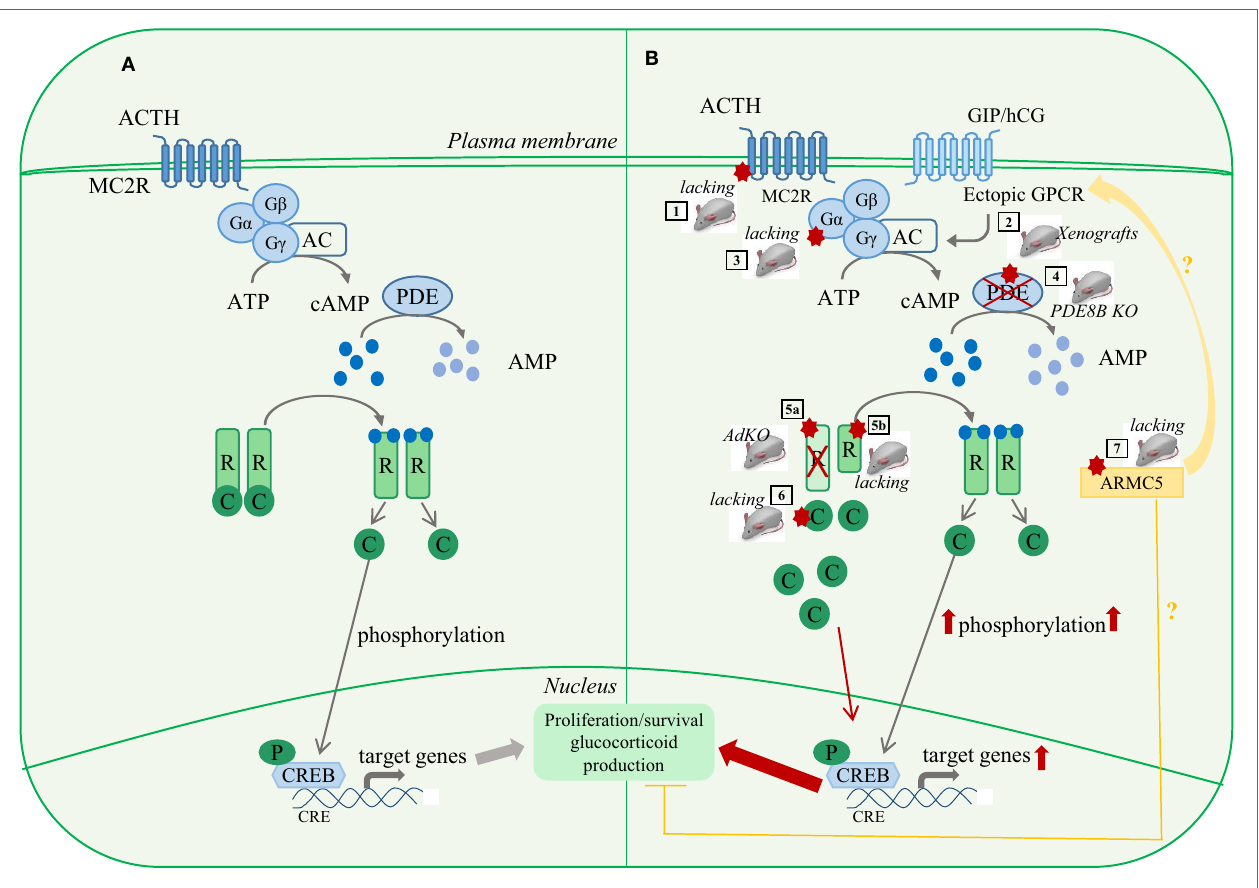
FiGURe 1 | PKA signaling pathway in adrenal tumorigenesis and related mouse models . (A) Under normal conditions, ACTH binds to MC2R, a G-protein-coupled receptor (GPCR) that activates adenylate cyclase (AC) via Gs α , thus increasing intracellular levels of cAMP. Upon binding of cAMP to regulatory subunits (R) of PKA, the complex dissociates releasing the catalytic subunits (C) which in turn phosphorylate (among others) the cAMP-responsive element-binding protein (CREB). Once phosphorylated, CREB transcription factor regulates the expression of steroidogenic and proliferative genes. In absence of ACTH, the pathway is repressed through the activity of several phosphodiesterases (PDE) that inactivate cAMP. (B) Molecular alterations of several components of cAMP/PKA signaling pathway cause adrenal hyperplasias and tumors. (1) Activating mutations of MC2R found in PBMAH patients lead to higher activation of the pathway. No mouse model is actually available for Mcr2 activating mutations. (2) Hormones other than ACTH (GIP/hCG/LH), through ectopic expression of several GPCRs, may induce ACTH-independent hypercortisolism in PBMAH patients. Xenograft mouse models nicely recapitulate this pathologic context. (3) Activating mutations in GNAS gene, encoding for the subunit α of the stimulatory G protein, causes higher activation of the pathway. These mutations are the cause of adrenal hyperplasia associated with Cushing’s syndrome in Mc-Cune Albright syndrome, whereas somatic mutations have been found in cortisol-producing adenomas. No mouse model is actually available for Gnas -activating mutations. (4) Inactivating mutations in PDE genes lead to an accumulation of cAMP, thus causing the persistent activation of the pathway in absence of ACTH and they have been associated with PBMAH and hypercortisolism. Whole-body PDE8B knockout mice developed mild hyperplasia. (5a) Most inactivating mutations in the PRKARIA gene, encoding the 1 α regulatory subunit (R1 α ) of the PKA, lead to aberrant transcripts and to the absence of the protein, resulting in constitutive activation of PKA. Adrenocortical-specific Prkar1a knockout (AdKO) mice develop a PPNAD-like syndrome with adrenal hyperplasia and ACTH-independent hypercorticosteronism. (5b) Some PRKARIA gene mutations lead to expressed mutated (truncated) R1 α proteins that also cause increased PKA activation. These mutations are associated with a more severe phenotype for reasons still not understood to date. No mouse model is available for expressed mutated R1 α proteins. (6) Mutations in the PRKACA gene encoding for the catalytic subunit α (C α ) of the PKA alter its interaction with regulatory subunits leading to constitutive activation of PKA-C α and increased steroidogenesis. These mutations have been identified in many patients with cortisol-producing adenomas. No mouse model is actually available for Prkaca activating mutations . (7) Inactivating germline and somatic mutations in the armadillo repeat-containing 5 ( ARMC5 ) gene have been identified in ~50% of patients with PBMAH. The function and the mechanisms by which ARMC5 contributes to the pathogenesis of PBMAH are unknown. In vitro studies suggest a role in steroidogenesis and apoptosis processes and a possible interplay with the PKA pathway, which is supported by the association of ARMC5 mutations with particular expression profile of GPCRs. No loss of function mouse model is actually available for